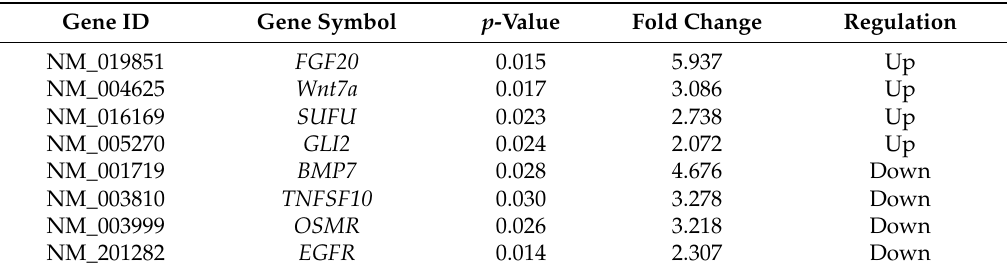
Table 2. Differentially expressed genes in response to NOMAC treatment in human endometrial cancer RL95-2 cells, according to cDNA microarray analysis. Gene ID Gene